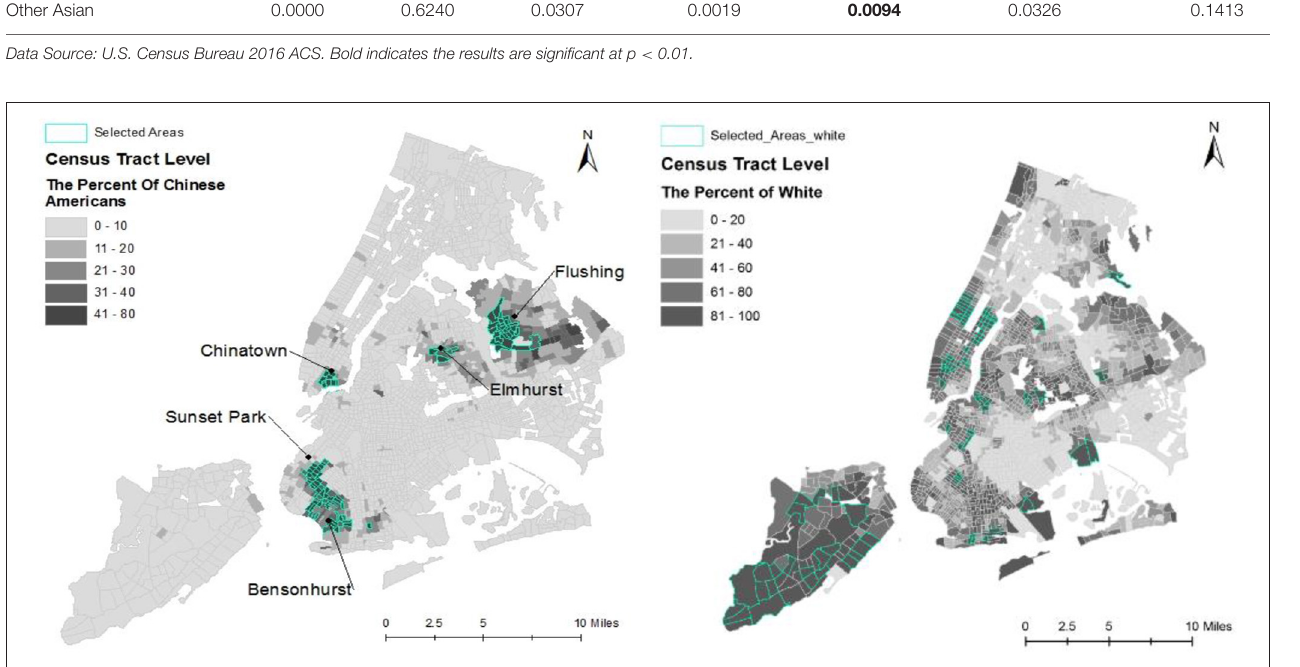
ethnic enclaves of Chinese Americans living in New York City (see Figure 6 , left